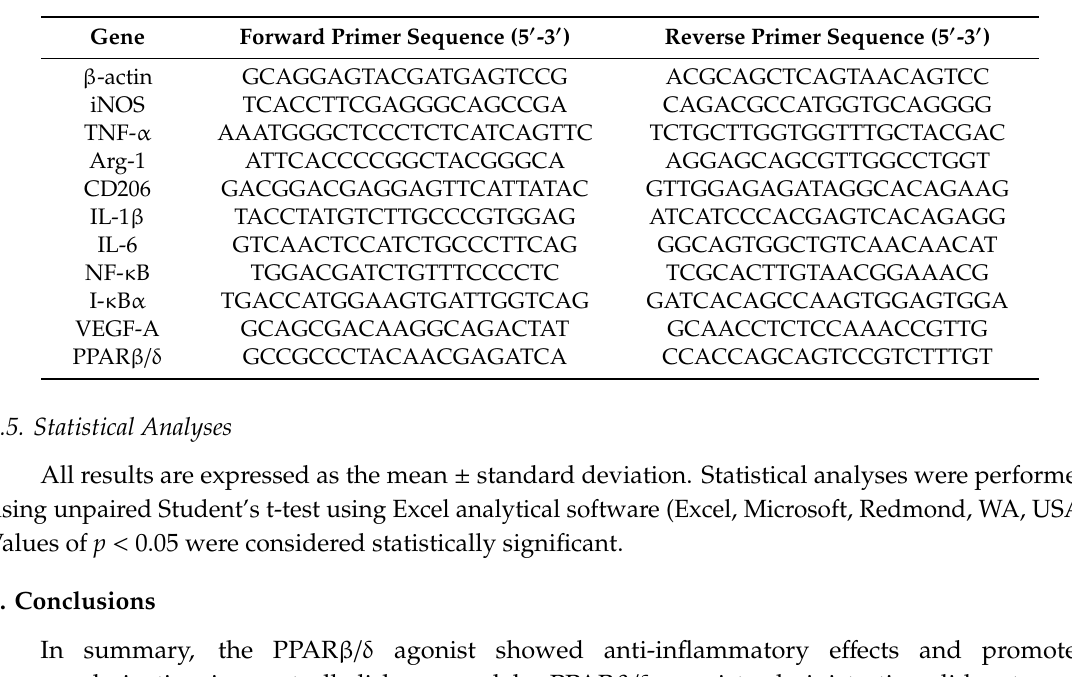
Table 1. Primer pairs used in this